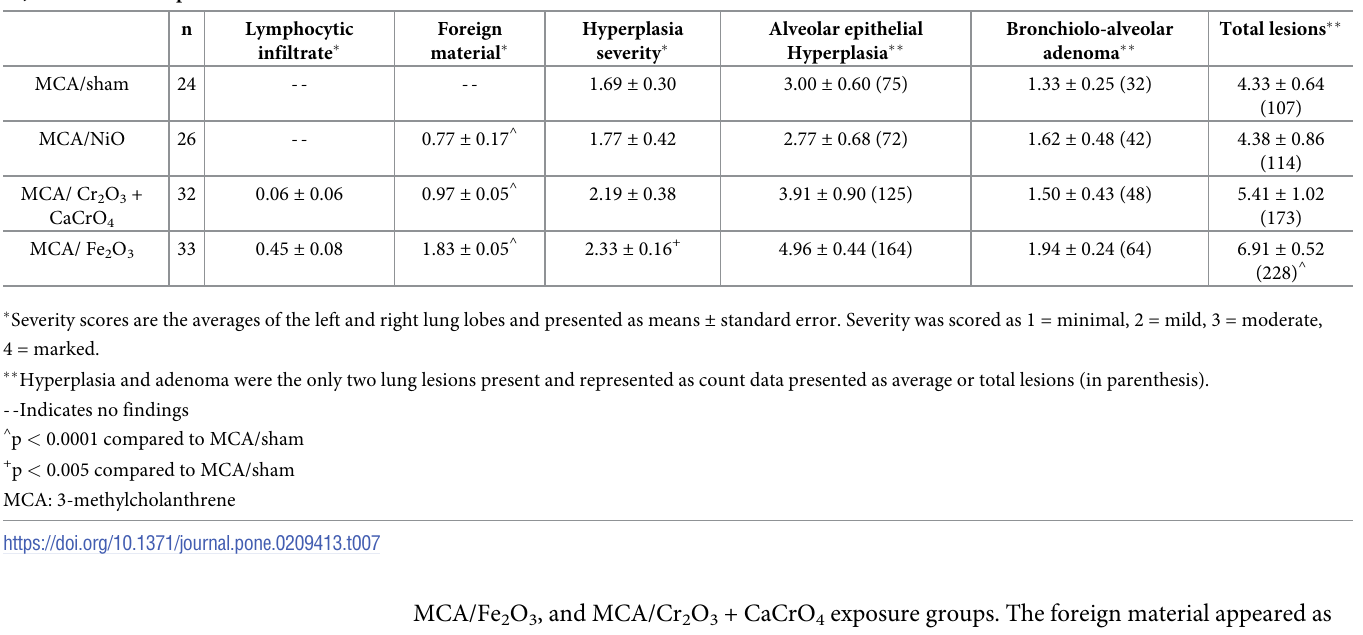
Table 7. Two stage (initiation-promotion) lung cancer bioassay: Lung histopathology severity scores for abnormal morphological findings and number of lesions in A/J mice at 30 weeks post-initiation. n